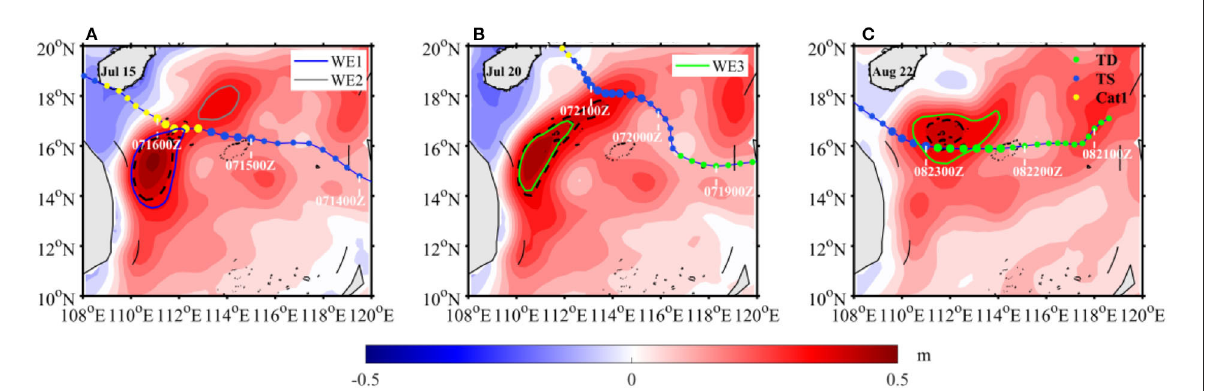
FIGURE1 The sea level anomaly (shading; unit: m) in the SCS on (A) 15 July, (B) 20 July, and (C) 22 August. The black dotted line represents the 0.4m SLA contour on the same day. Green, blue, and yellow dots indicate the tropical depression, tropical storm, and Category 1 typhoon (based on the Saffir-Simpson scale), respectively. The bigger dots represent the locations of TC passing over the warm eddy. Blue, gray, and green contours represent the boundary of WE1, WE2, and WE3, respectively. The tracks and locations of TC1/Conson in (A) , TC2/Chanthu in (B) , and TC3/Mindulle in (C) are